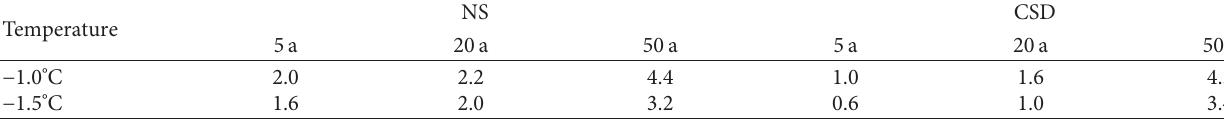
Table 3: Variation of the permafrost table under different boundaries (unit: m).